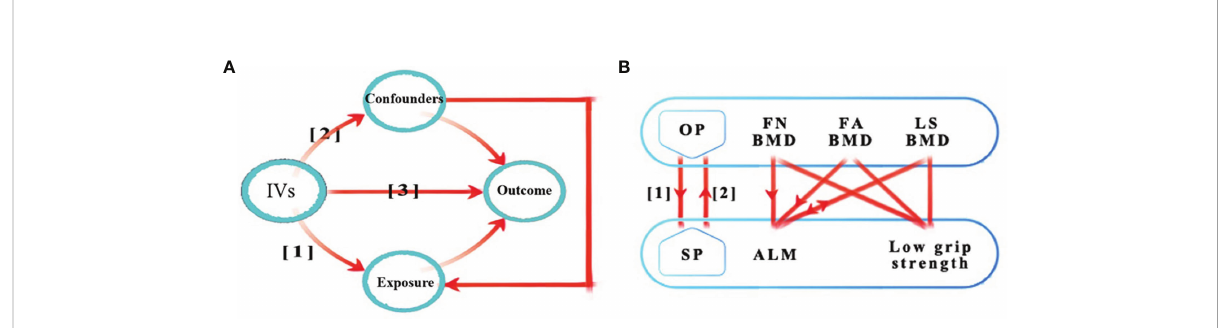
FIGURE 1 Schematic representation of the three assumptions and study design. (A) (1) The used genetic IVs are robustly associated with exposure; (2) The slected IVs are not associated with potential confounders; (3) The IVs can only affect the risk of outcome dependently through exposure. (B) This bidirectional MR analysis was performed in two steps: osteoporosis was studied as exposure while sarcopenia-related traits were studied as outcome in the fi rst step, whereas the second step was reversed. The arrows indicate direction of causality in our results. IVs, instrumental variables; OP, osteoporosis; SP, sarcopenia; FA, forearm; FN, femoral neck; LS, lumbar spine; BMD, bone mineral density; ALM, appendicular lean mass; MR, mendelian